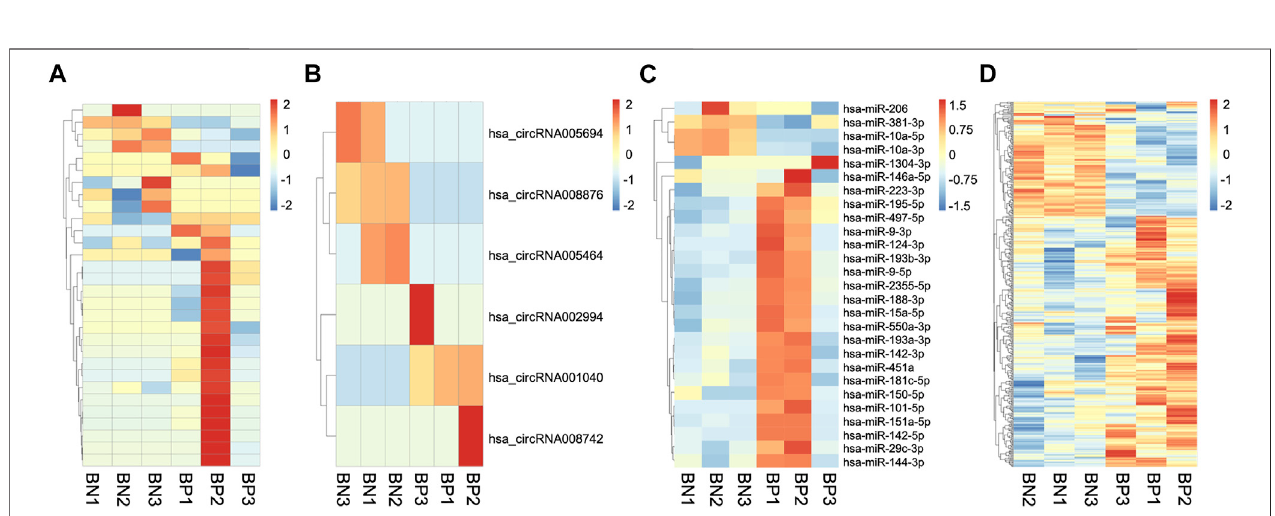
FIGURE 2 | Expression pro fi les of mRNAs and ncRNAs. Heatmaps clustering of all signi fi cantly DE lncRNAs (A) , circRNAs (B) , miRNAs (C) and mRNAs (D) in hBMSCs of three senile osteoporosis patients (BP1, BP2, and BP3) and three normal individuals (BN1, BN2, and BN3).